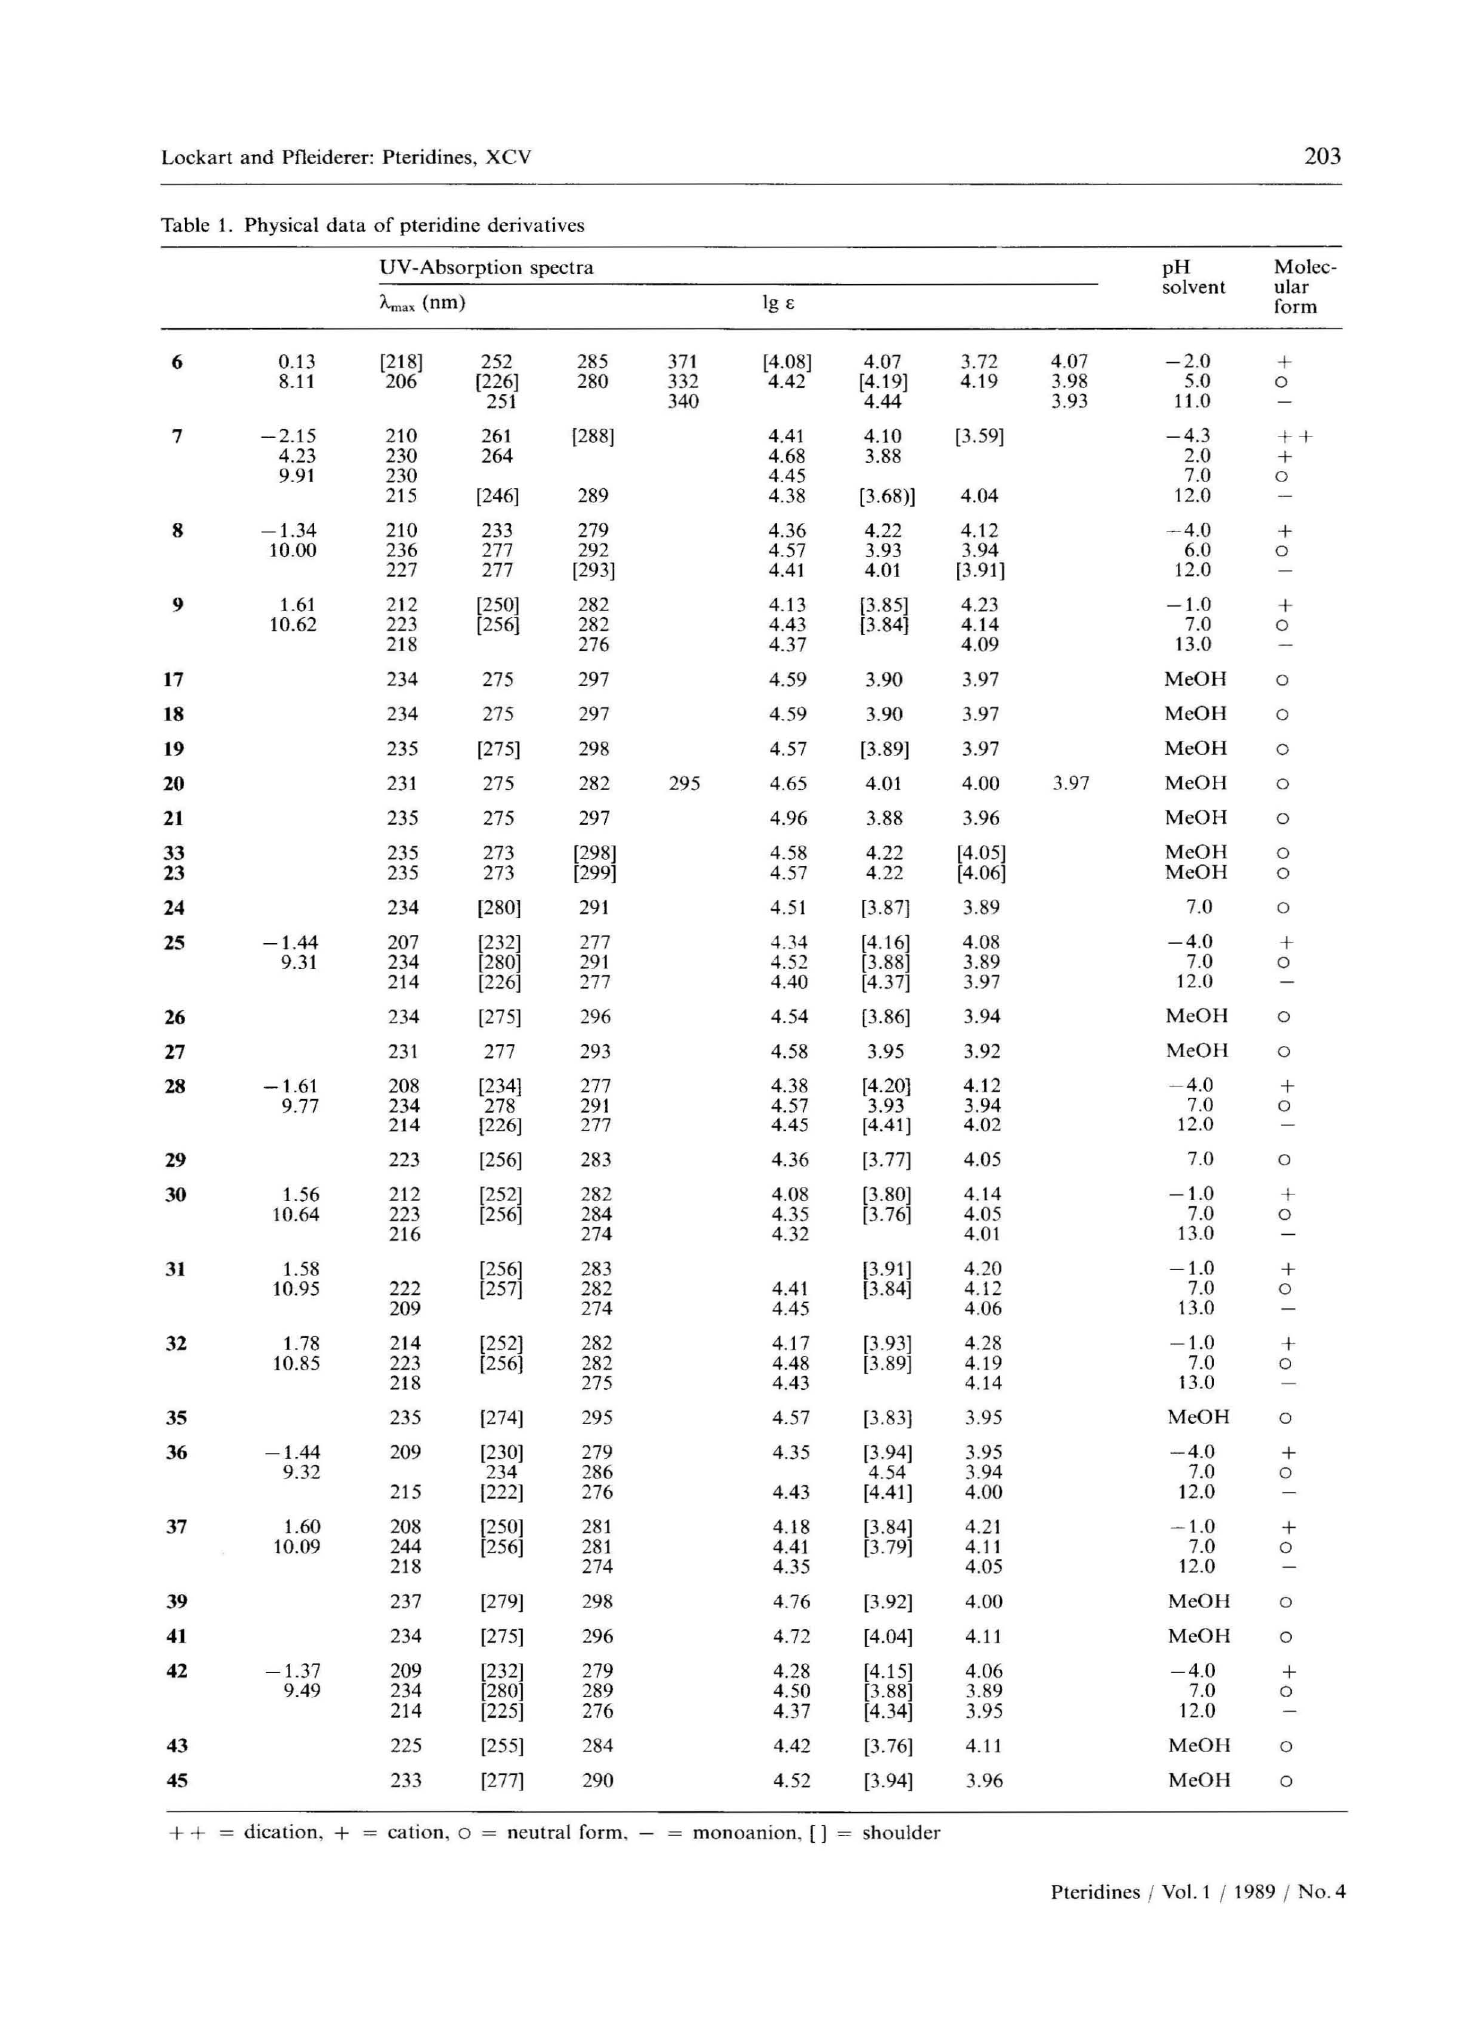
Table 1. Physical data of pteridine